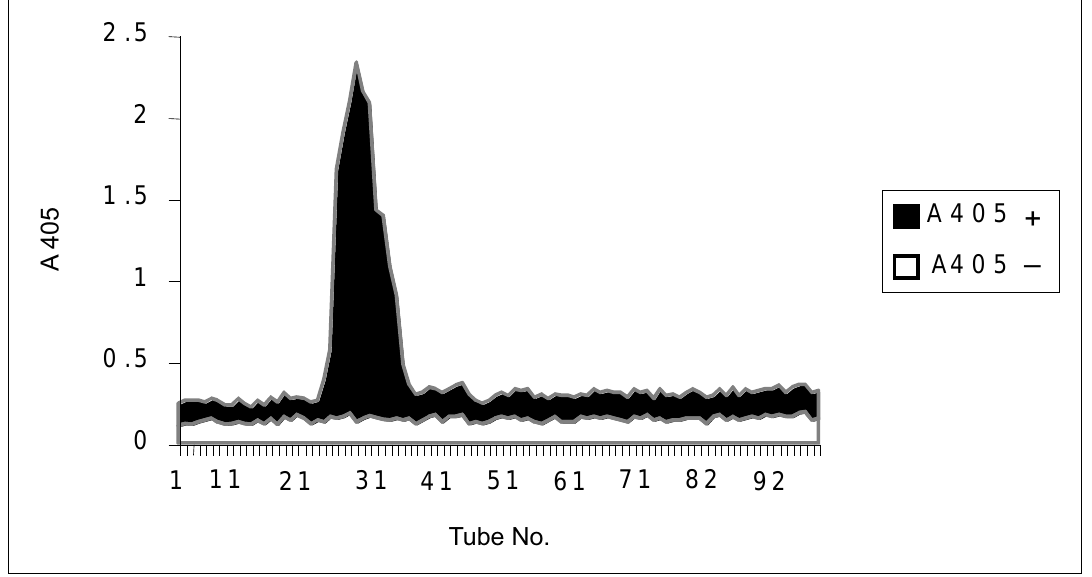
Fig. 2. Virus detection by ELISA in the same CTV preparation as Fig. 1 after Sephacryl 300 column chromatogra-